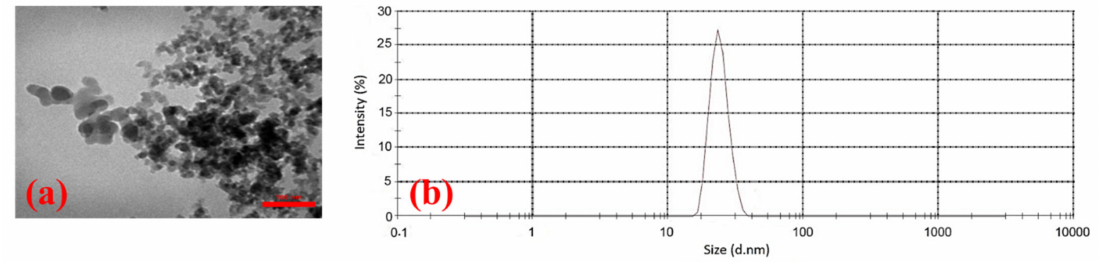
Figure 2. ( a ) TEM image and ( b ) DLS analysis of the